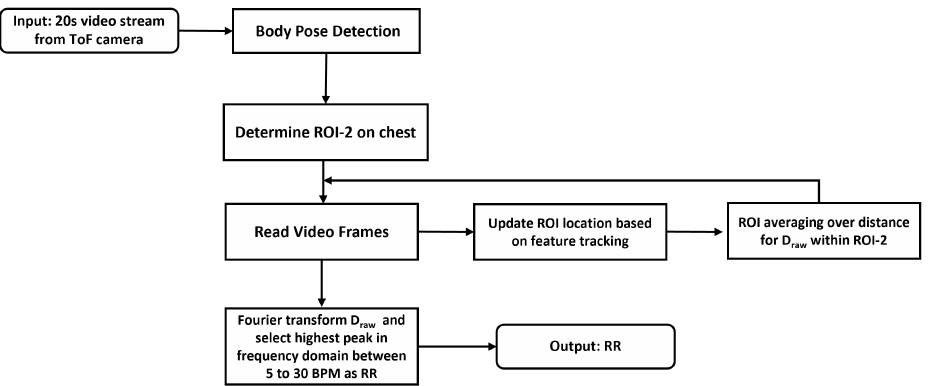
Figure 5. Processes to extract RR while driving using depth and grayscale information from a ToF